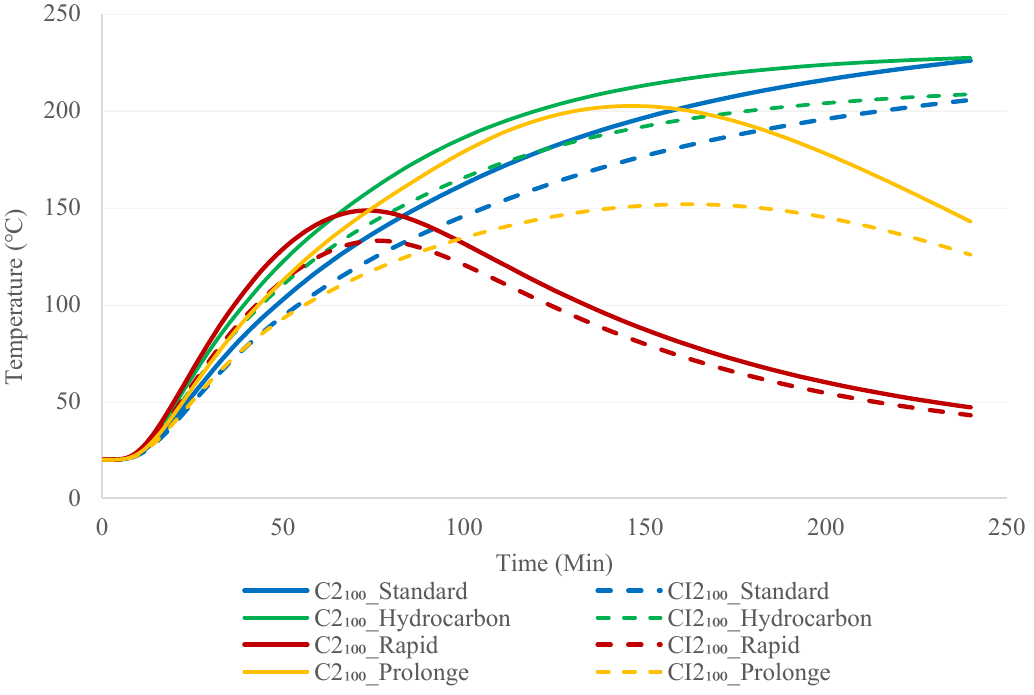
Figure 13. Unexposed surface temperature changes of 100mm wall configurations C2 and CI2 under different fire conditions.